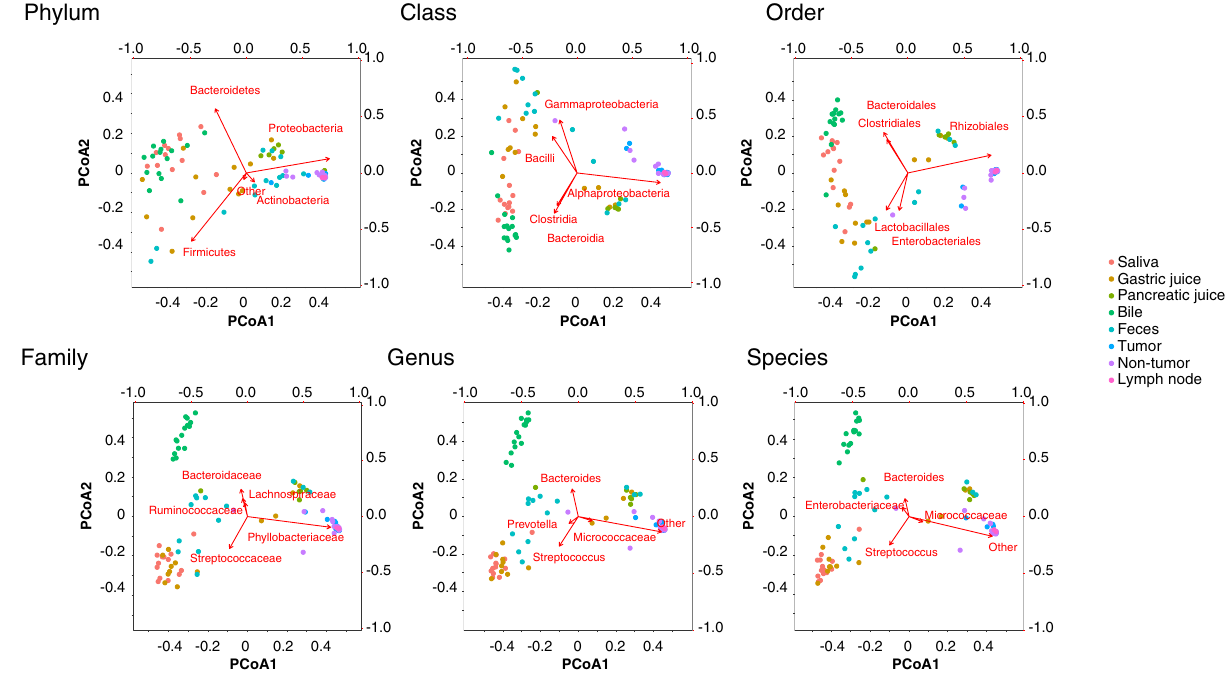
Figure 3. PCoA in each taxonomy level. Calculation was based on the relative abundance at each taxonomic level.